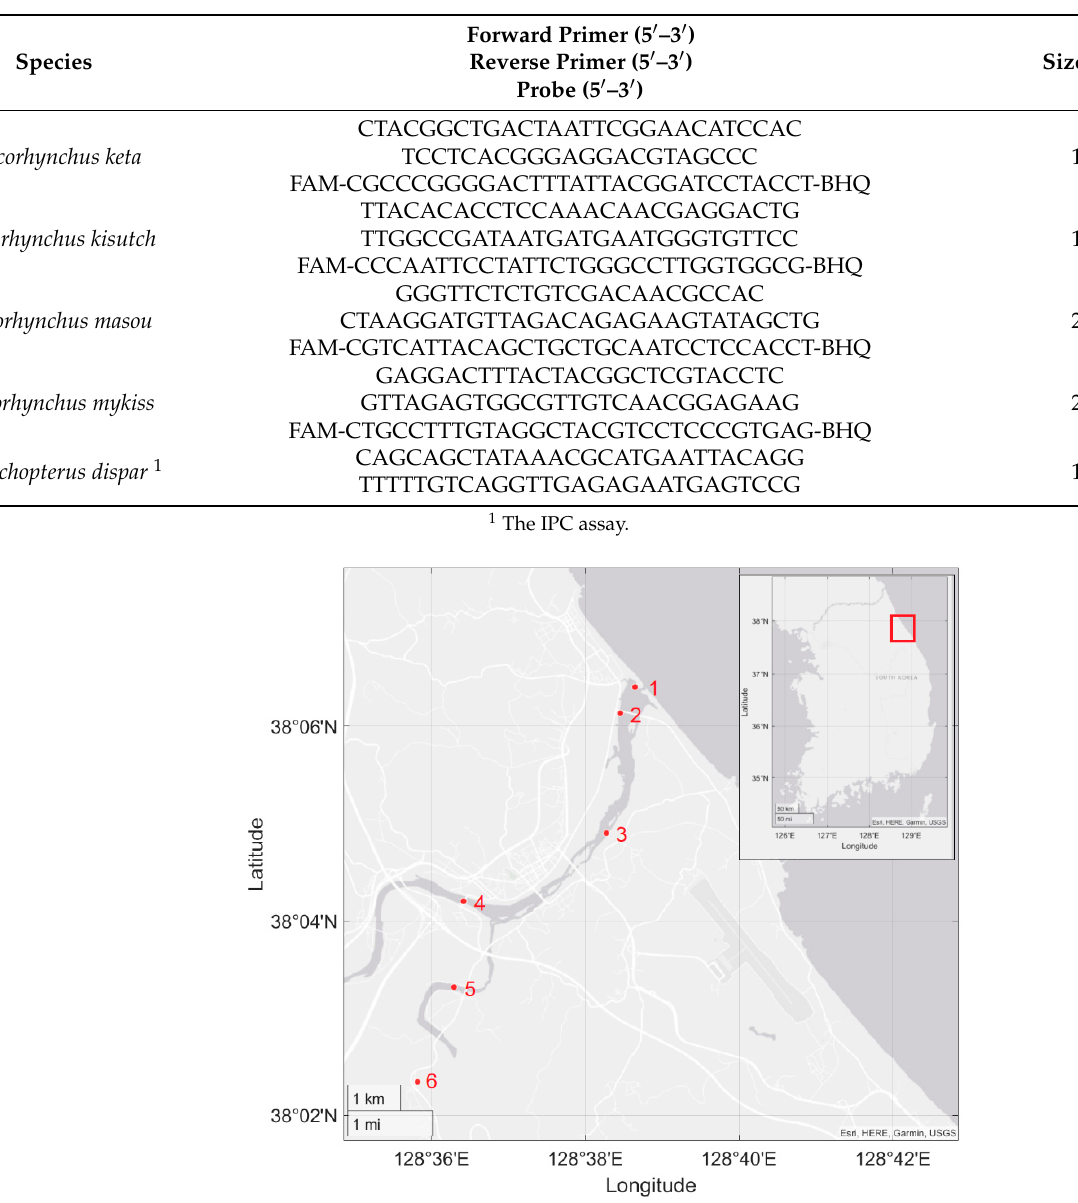
Table 1. Primers and probes used to detect four Oncorhynchus spp. in South Korea and the internal positive control (IPC) assay.